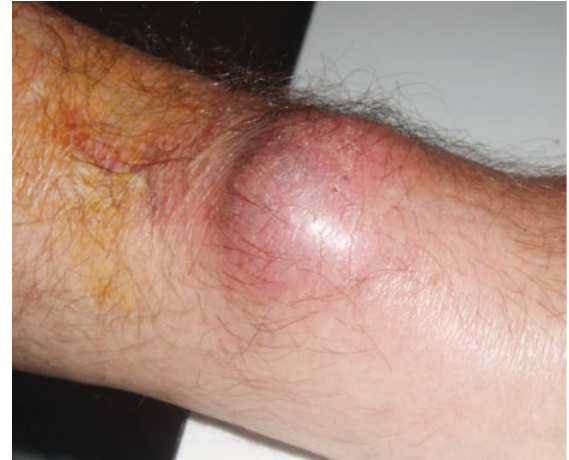
Figure 1. Enlarged bursa in the dorsal aspect of patient right wrist.